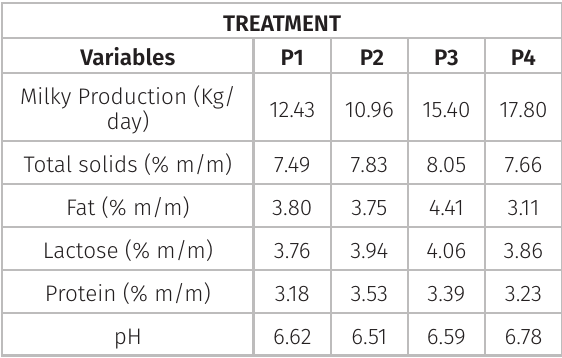
Table I. Physico-chemical composition of the milk used in the production of ripened